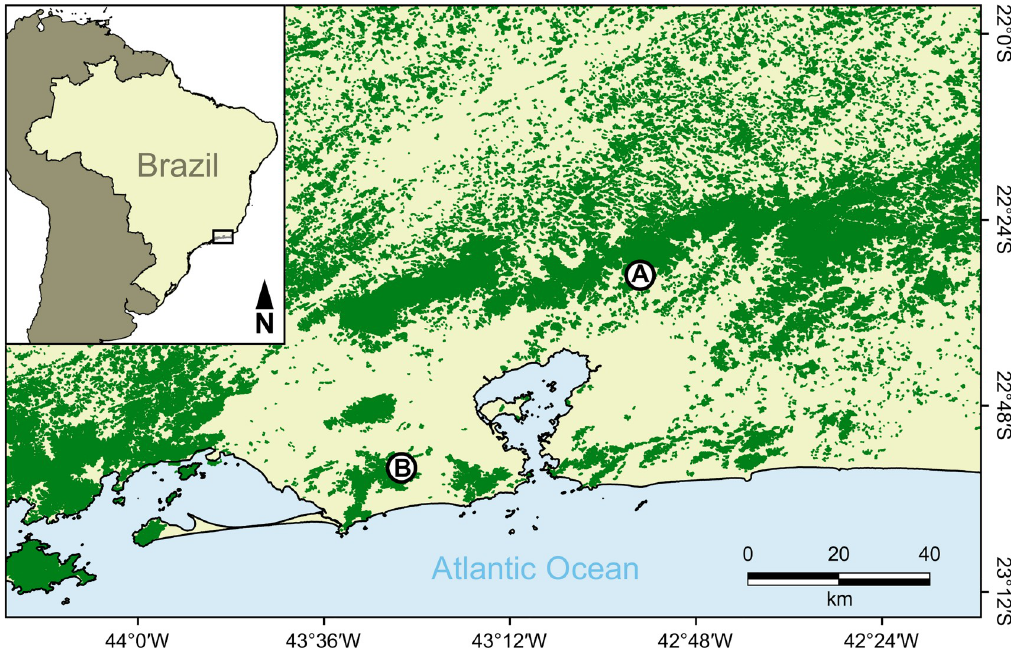
Fig 1. Map of part of Rio de Janeiro state, southeastern Brazil, showing the Atlantic Forest remnants (green) where bats were sampled: Reserva Ecolo´gica de Guapiac¸u (A) and Estac¸ ã o Biolo´gica Fiocruz Mata Atlaˆntica (B).